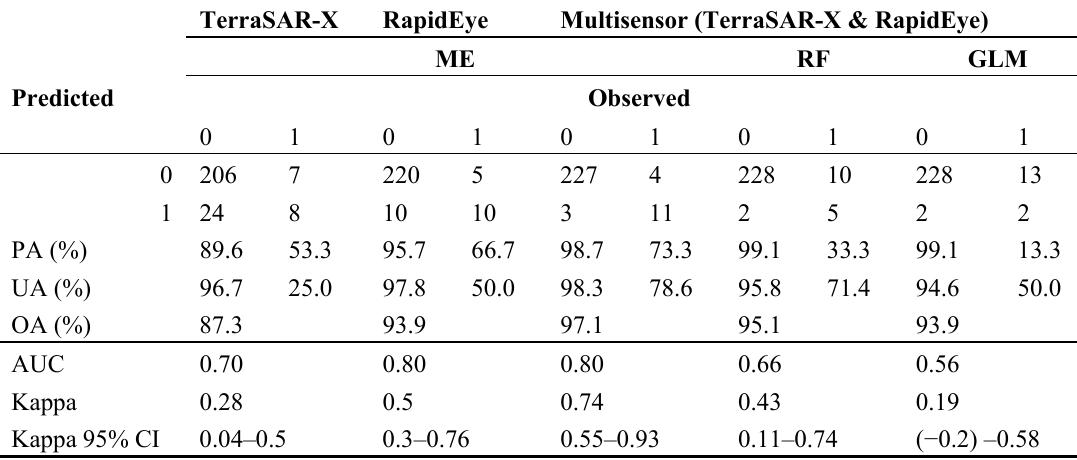
Table 3. Confusion matrices and performance of the best models after cross validation (0 = Background (n = 230 plots); 1 = Green attack (n = 15 plots); ME = maximum entropy; RF = random forest; GLM = generalized linear model).